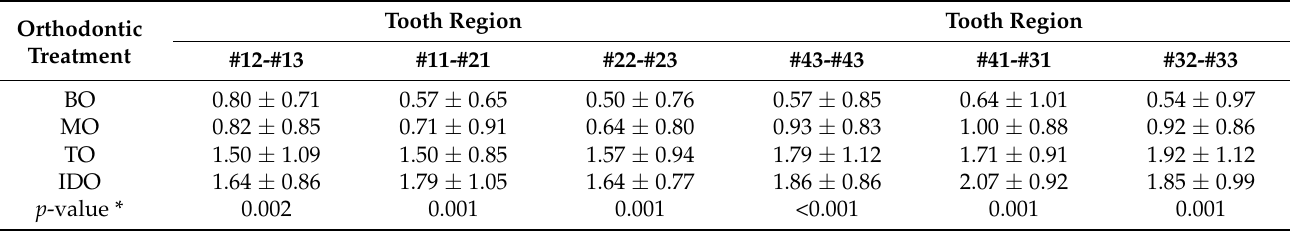
Table 3. GI of papillary gingivitis in the IOPs.